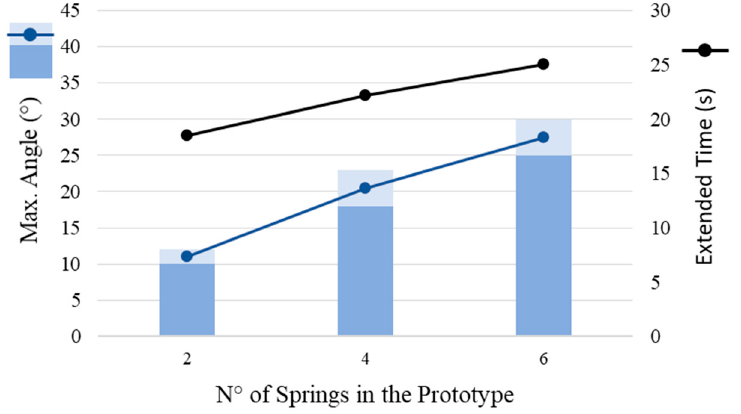
Figure 11. Maximum angle of inclination of the prototype (blue) and extended time as a function of the number of NiTi springs (black) in PA12 support.